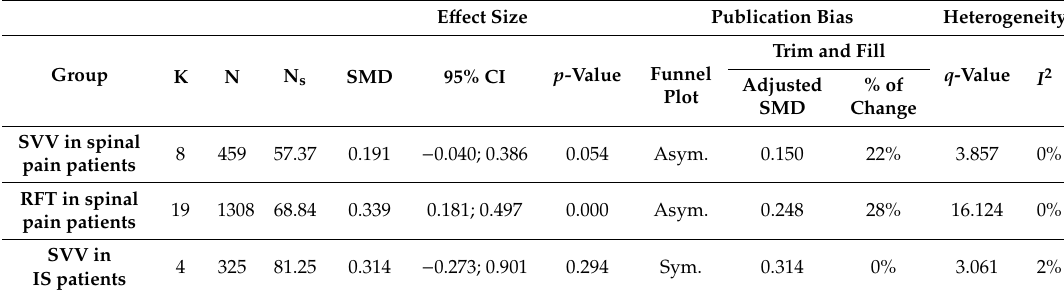
Table 4. Summary of findings in the meta-analyses.